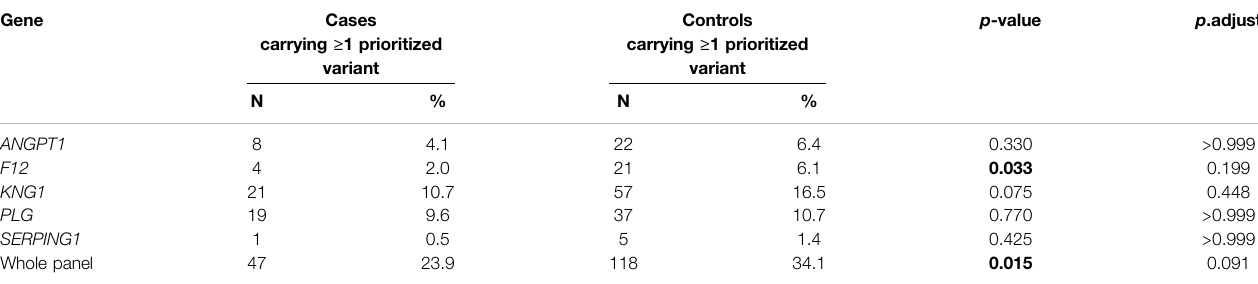
TABLE 3 | Enrichment analysis of rare, potentially functional variants in the fi ve investigated